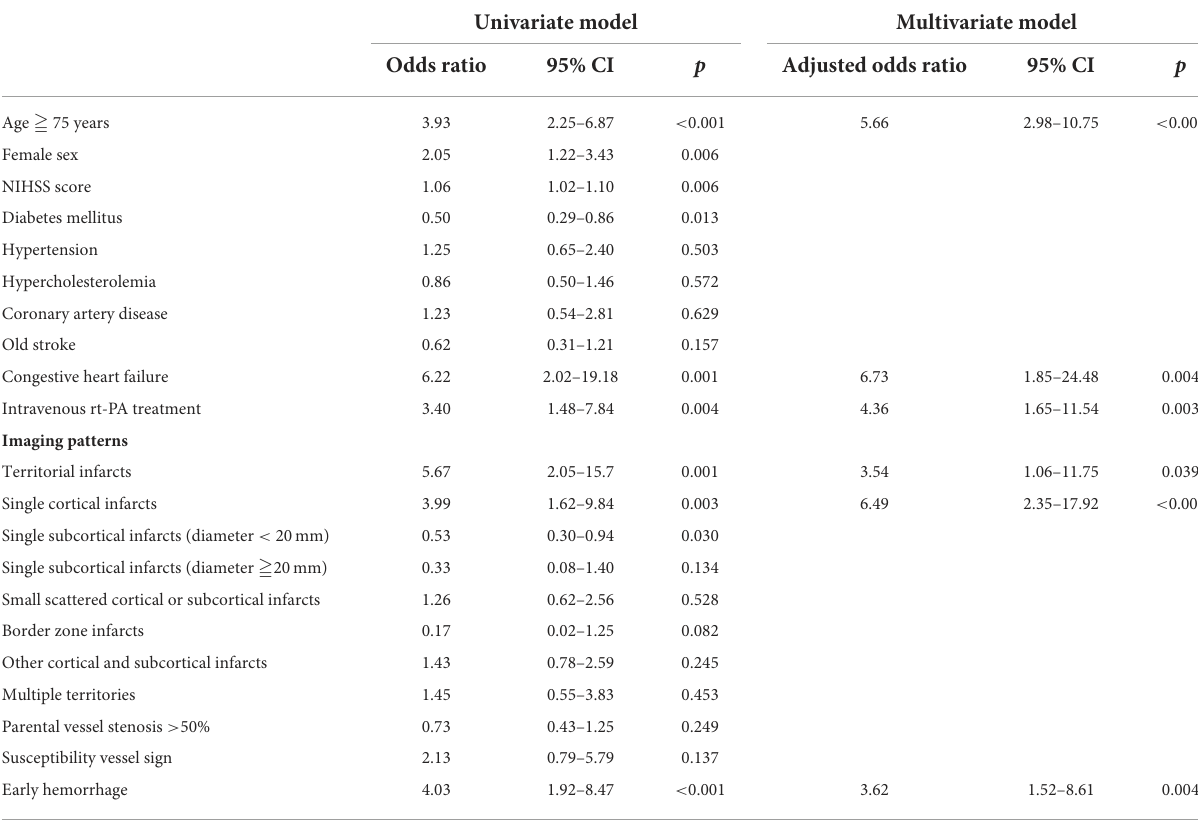
TABLE 2 Logistic regression for the predictors of newly detected atrial fibrillation in the patients with acute ischemic stroke. Univariate model